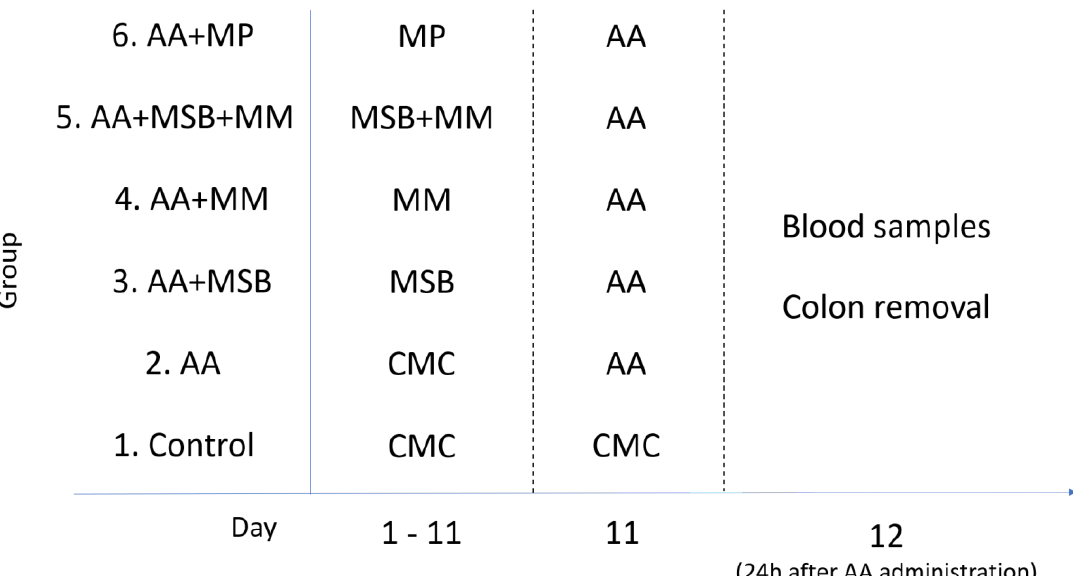
Figure 1. Experimental study design. Abbreviations: CMC, carboxymethylcellulose; AA, 4% acetic acid; MSB, MegaSporeBiotic™; MM, MegaMucosa™; MP, methylprednisolone.